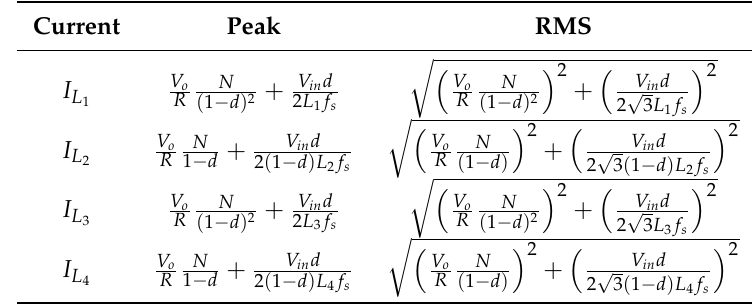
Table 4. Inductor peak and RMS